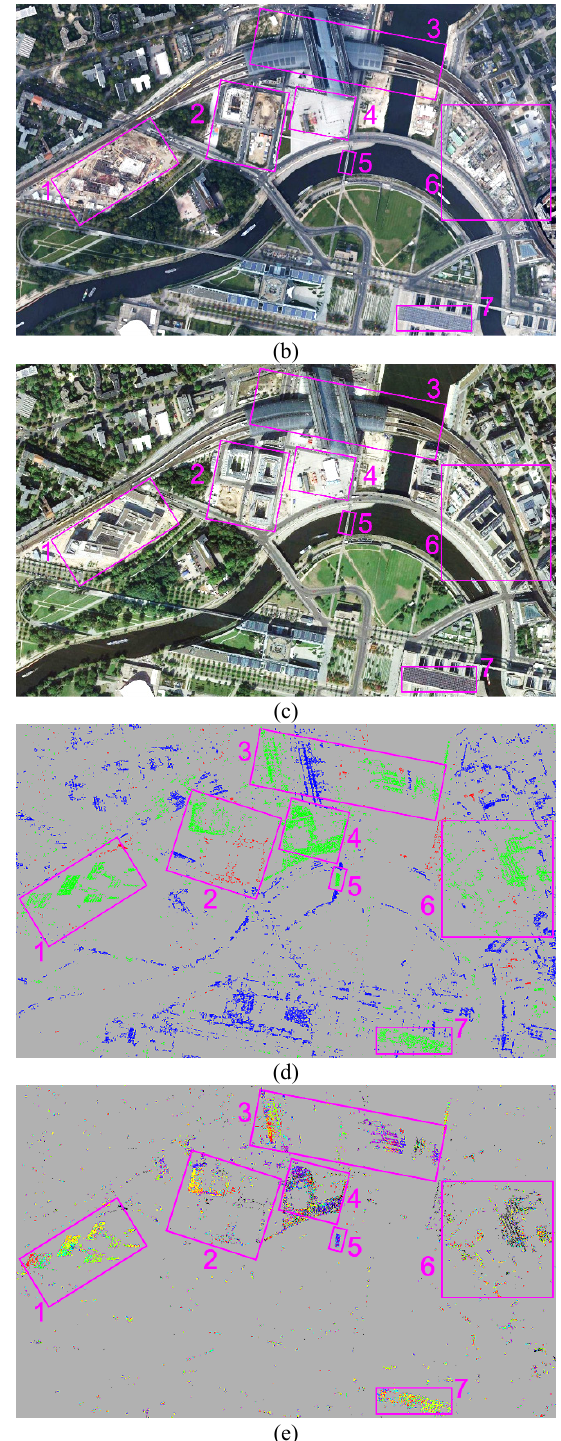
Figure 5. Construction monitoring in patch 1 (Figure 3) around Berlin Central Station. Areas 1 to 7 are used for in-depth analysis. GE images were acquired on (a) September 12, 2010, (b) May 20, 2012, and (c) September 5, 2014. (d) and (e): spatiotemporal change detection result in patch 1 (Figure